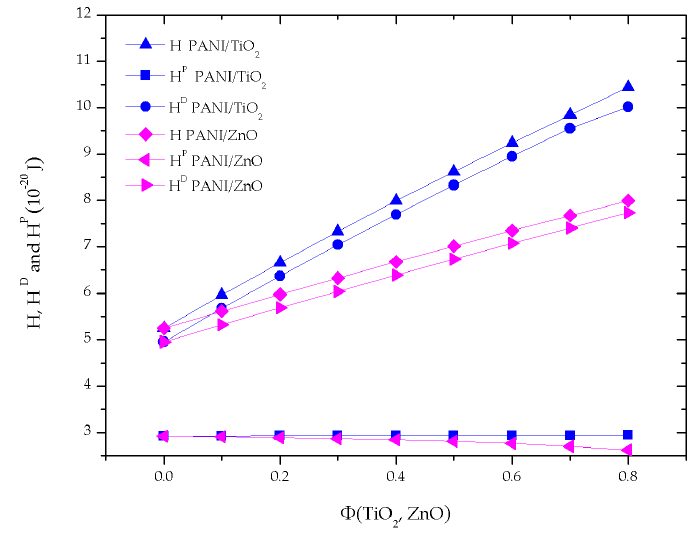
Figure 3. The nonretarded Hamaker constants as a function of the volume fraction Φ of NPs for PANI/NPs ‐ Water across air.